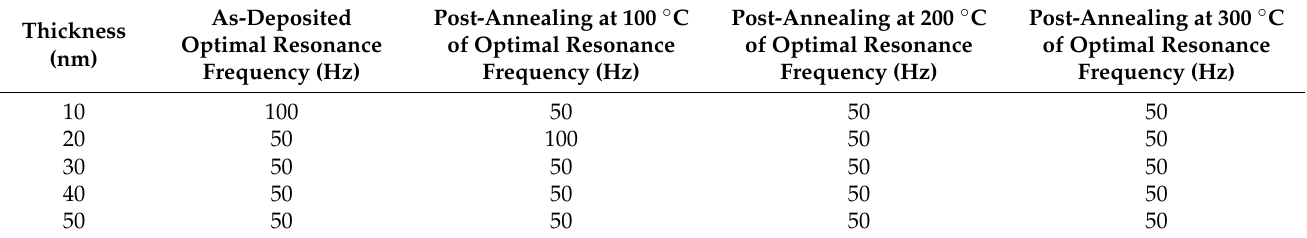
Figure 8. Maximum alternate-current magnetic susceptibility for Co 40 Fe 40 Yb 20 thin films. Table 4. The optimal resonance frequency for various thicknesses of films.